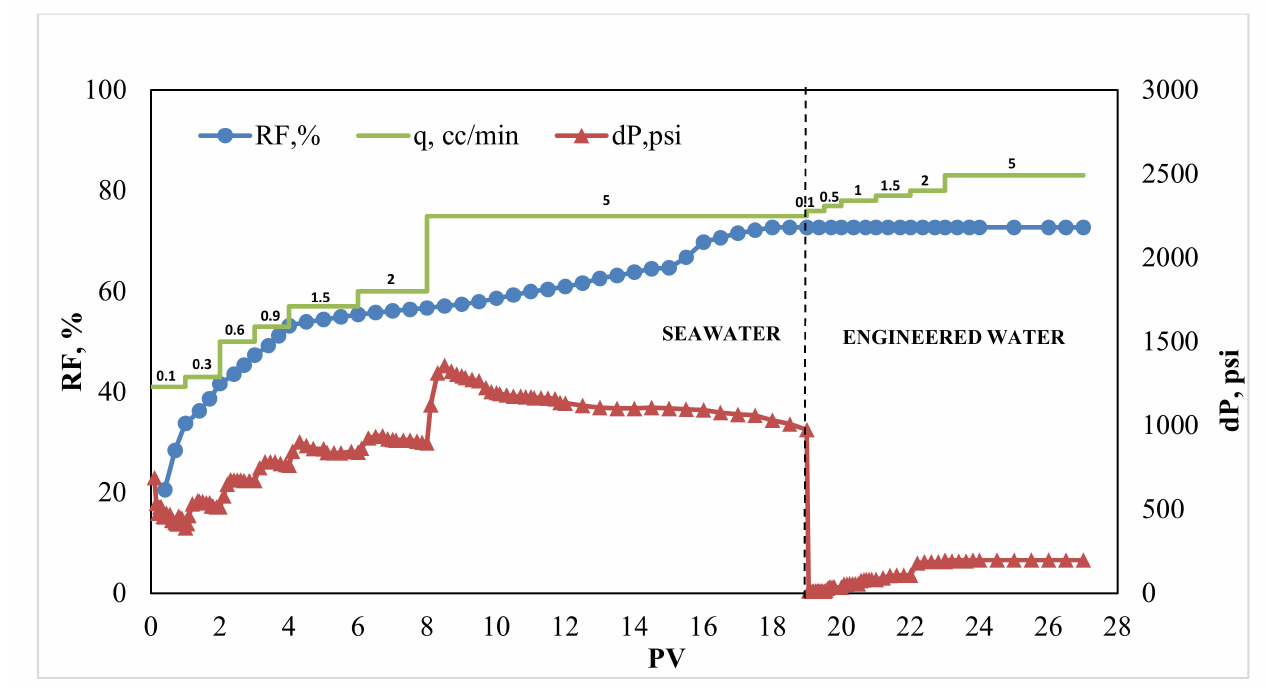
Figure 3. Low salinity water injection (5 × Diluted CSW) core flooding results.